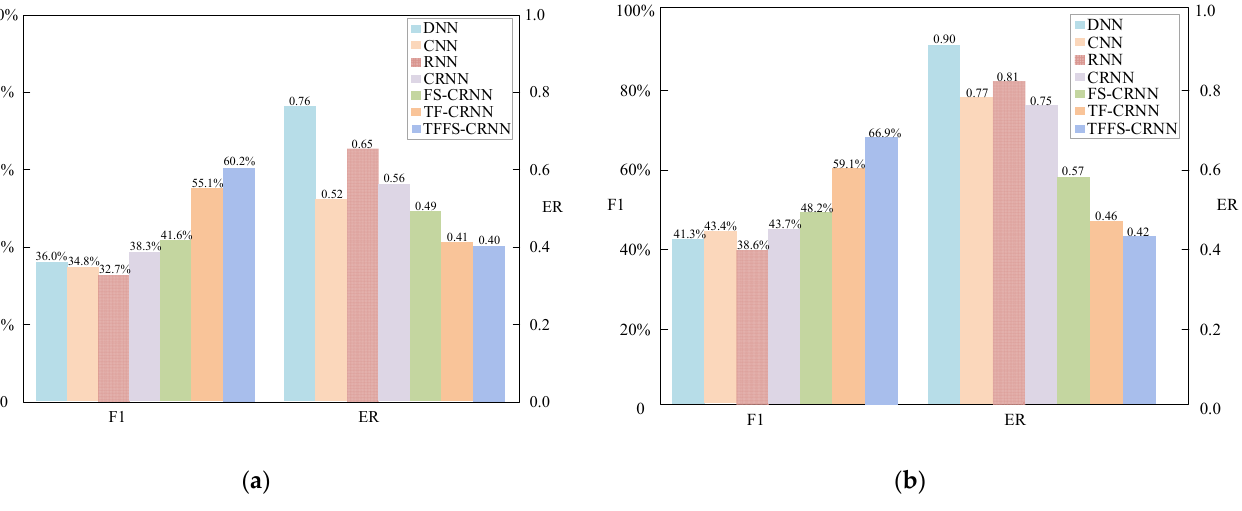
Figure 6. The results of different classifiers in the evaluation dataset. The figure ( a ) is the experimental result of the DCASE 2016 Task3 dataset; the figure ( b ) is the experimental result of the DCASE 2017 Task3 dataset. Table 5. The results of different classifiers.